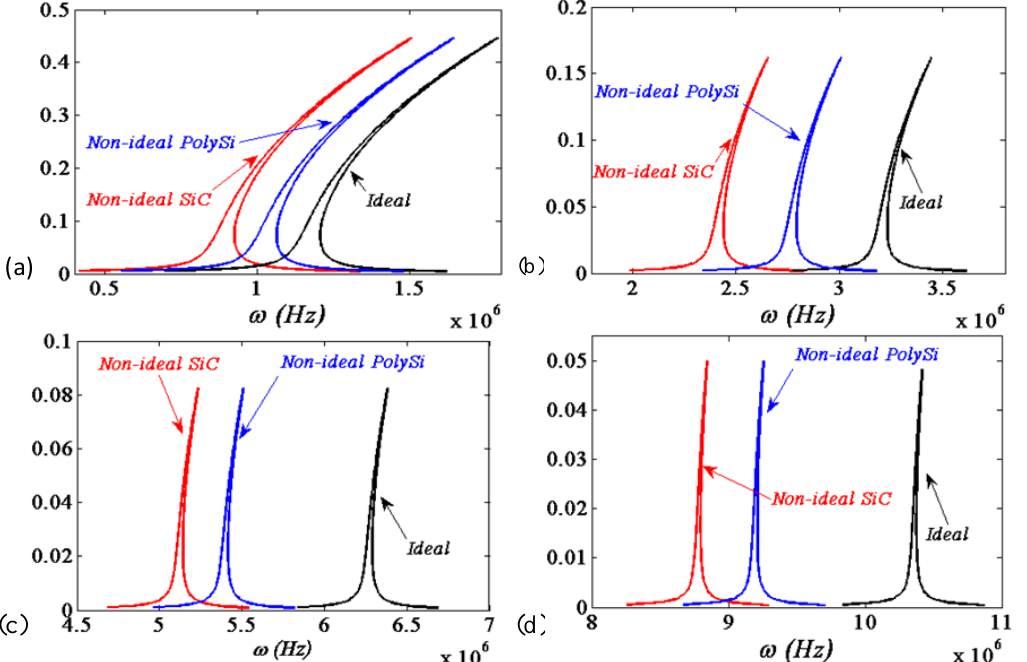
Figure 4. First four resonance response curves. (Black) Ideal boundary conditions. (blue), (red) non-ideal boundary conditions with the supports material of silicon carbide